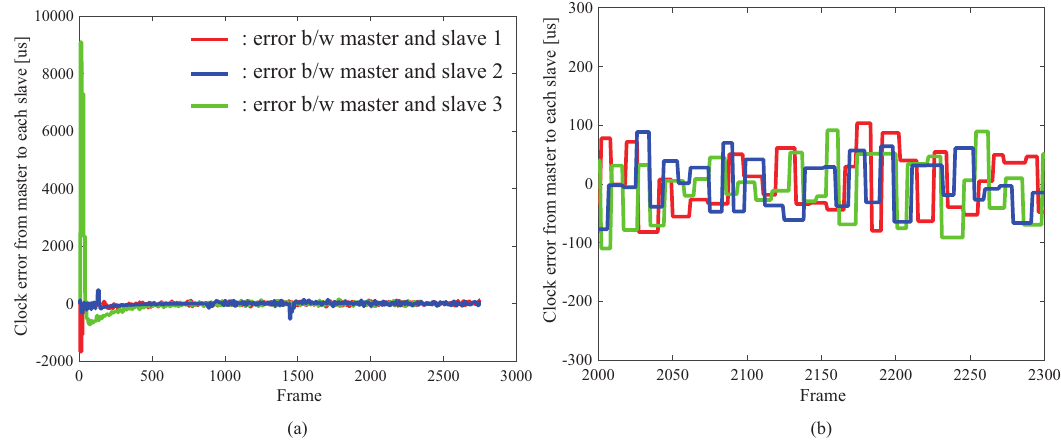
Figure 2. Clock synchronization: ( a ) shows overall result and ( b ) shows enlarged result.